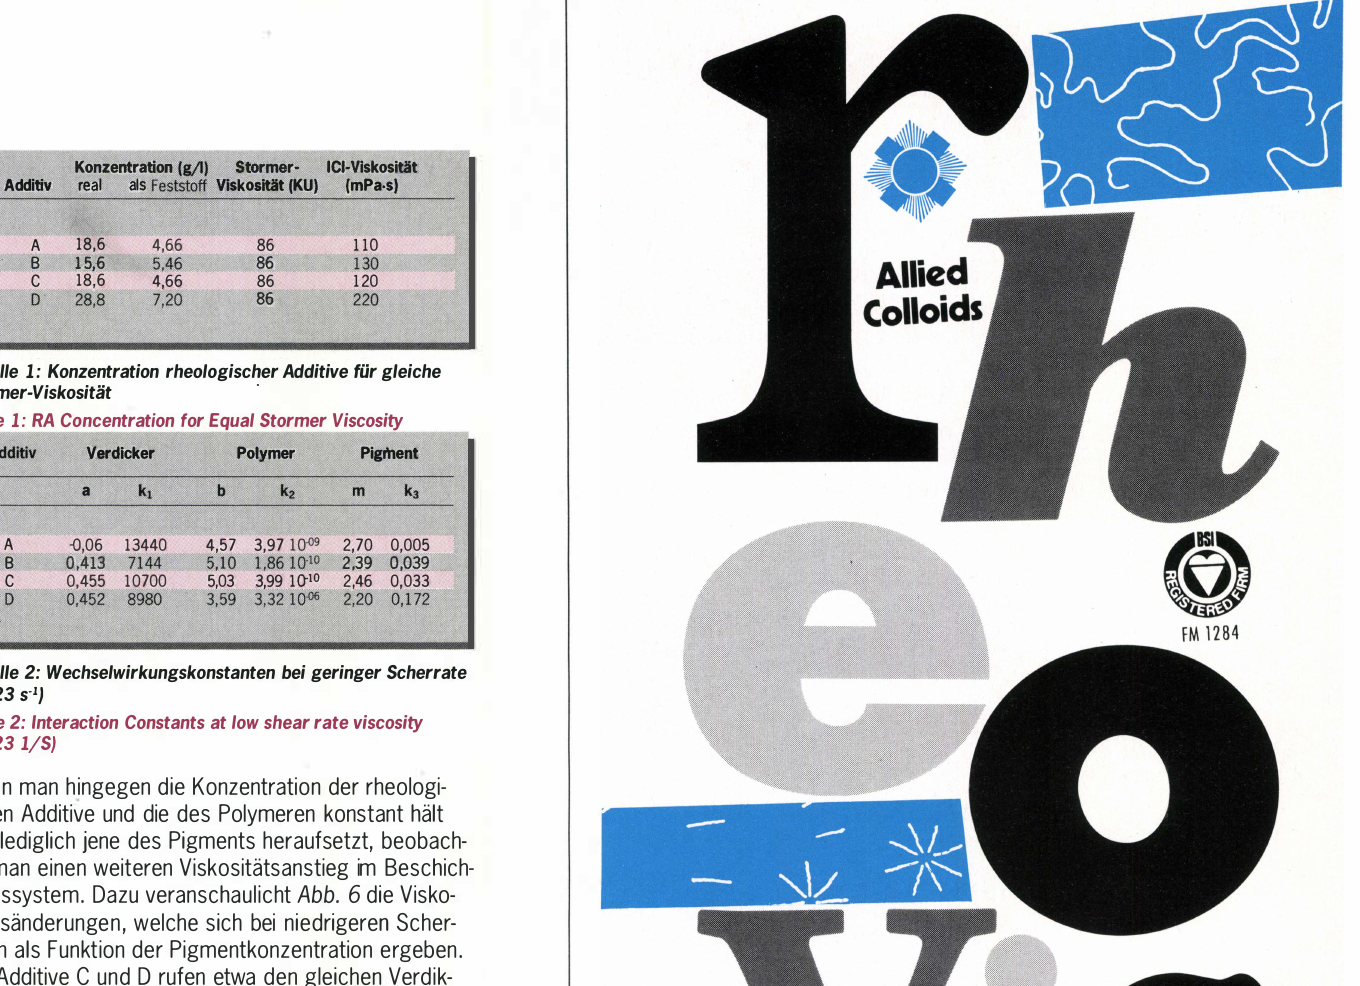
Wenn man hingegen die Konzentration der rheologi· schen Additive und die des Polymeren konstant